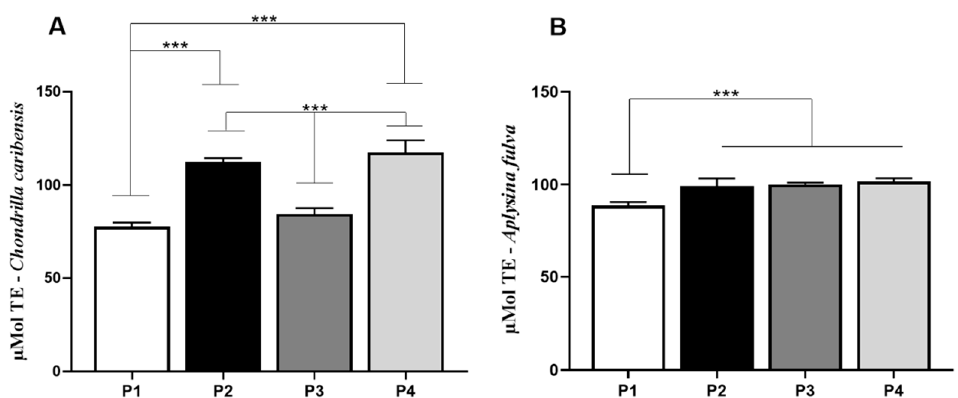
Figure 9. Means and standard deviations of the concentration in µ Mol TE/g extract for P1, P2, P3, and P4 extracts for C.